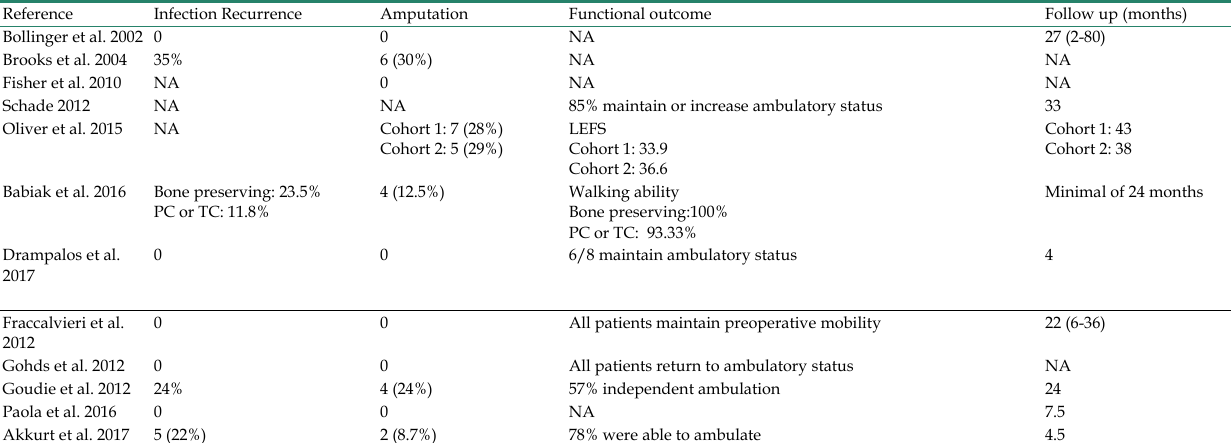
Table 2 : Systematic review of studies describing bone treatment for calcaneal osteomyelitis. Results and follow up.